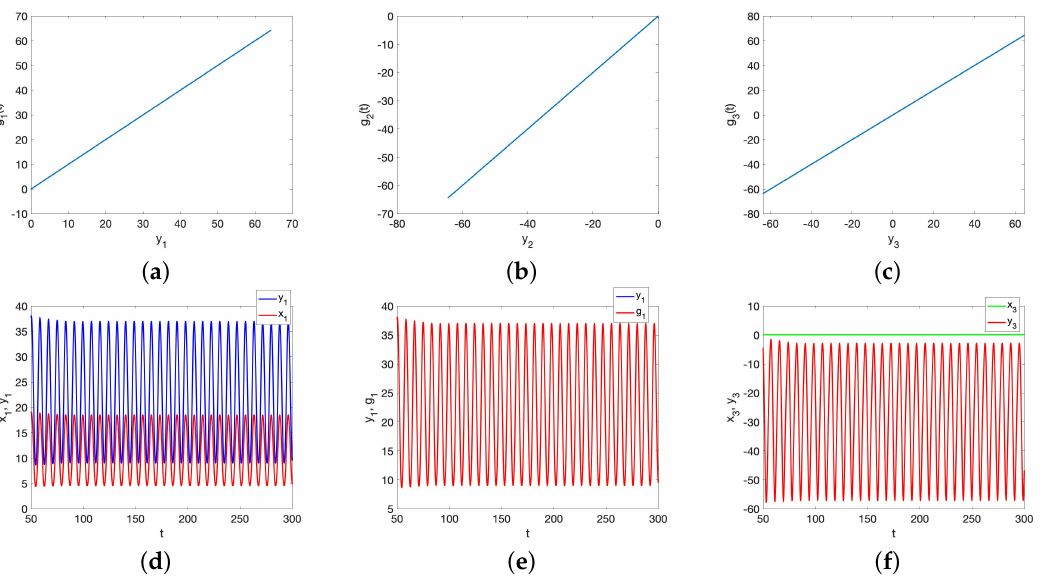
Figure 5. GS with small initial data. ( a ) y 1 − g 1 plot showing a 1:1 correlation. ( b ) y 2 − g 2 plot showing a 1:1 correlation. ( c ) y 3 − g 3 plot showing a 1:1 correlation. ( d ) Simulation showing time evolution for x 1 and y 1 after transients die out. ( e ) Simulation showing time evolution for g 1 and y 1 after transients die out. ( f ) Time series plot showing no blow-up in x 3 after transients die out.